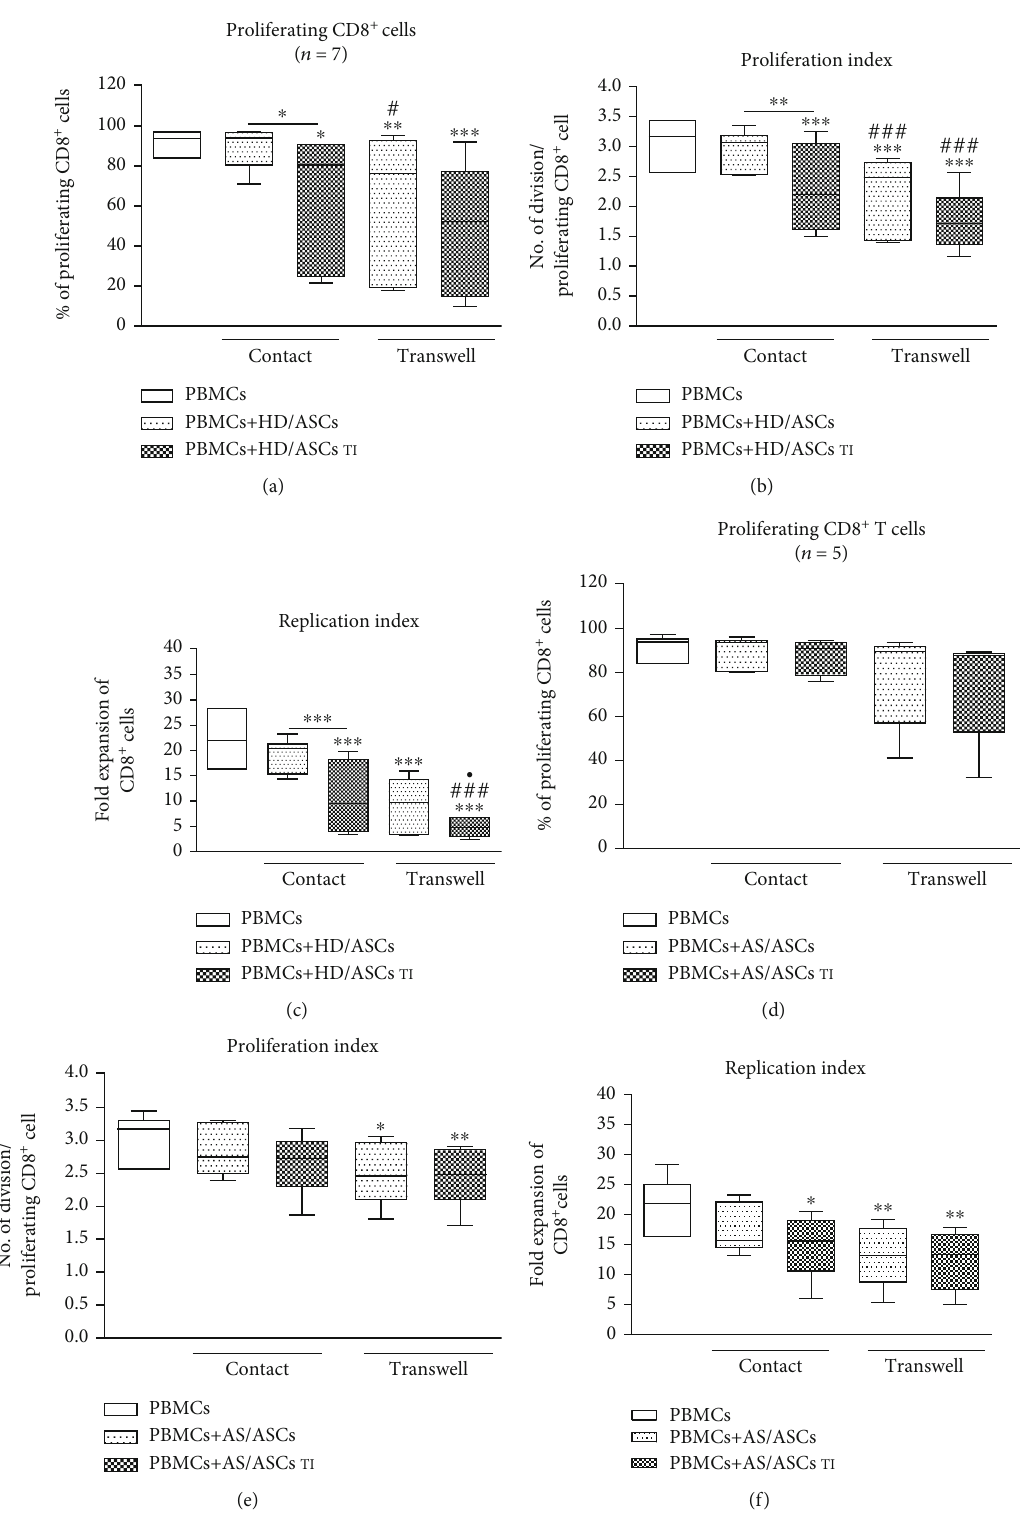
Figure 3: Comparison of ASC inhibitory e ff ects on CD8 + T cell proliferation in contact and transwell cocultures. Cell origin and culture conditions as in Figure 2, except that CD8+ T cells were analyzed. ∗ P = 0 : 05 ‐ 0 : 01 , ∗∗ P = 0 : 01 ‐ 0 : 001 , and ∗∗∗ P = 0 : 001 ‐ 0 : 0001 for comparison of cell cocultures vs. control separate cultures and as indicated. # P = 0 : 05 ‐ 0 : 01 and ### P = 0 : 001 ‐ 0 : 0001 for comparison of contact vs. transwell